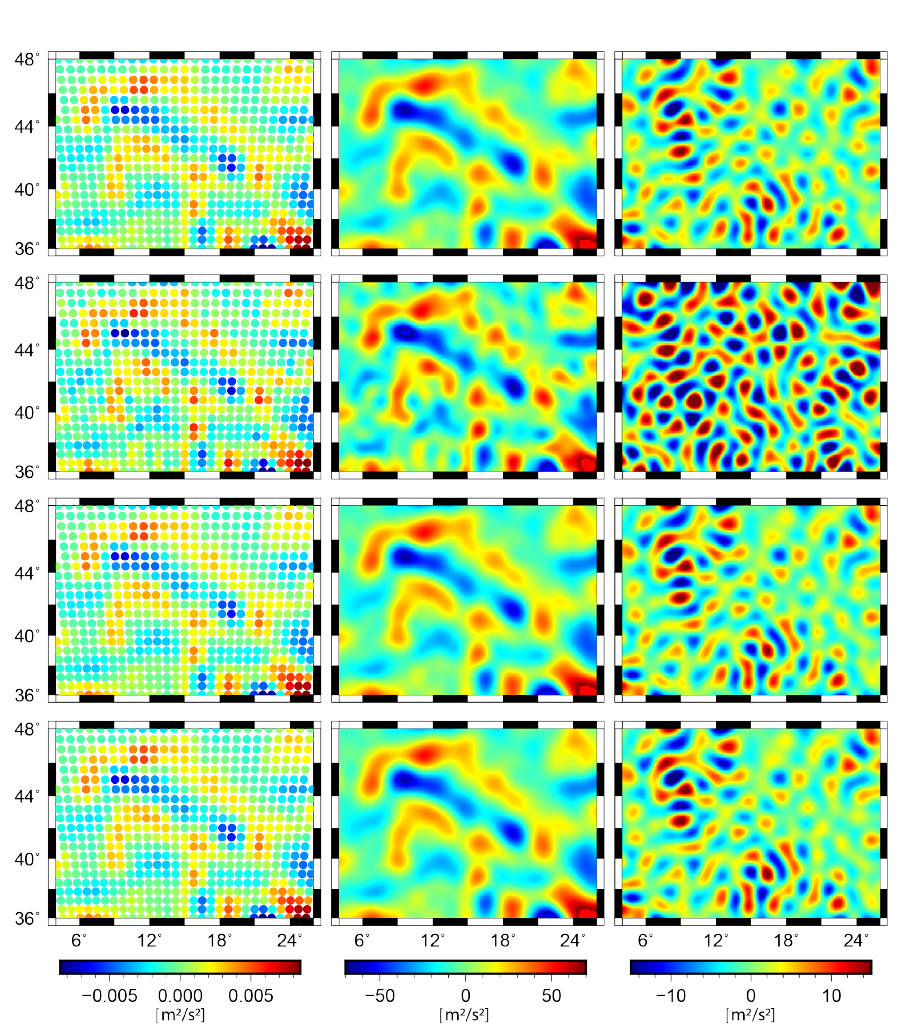
Figure 7. The estimated coefficients d k ( left column ), the recovered disturbing potential T c ( mid column ), and the differences w.r.t the validation data ( right column ) for study case A. The results are obtained using: the L-curve method ( first row ), VCE ( second row ), VCE-Lc ( third row ), and Lc-VCE ( fourth row